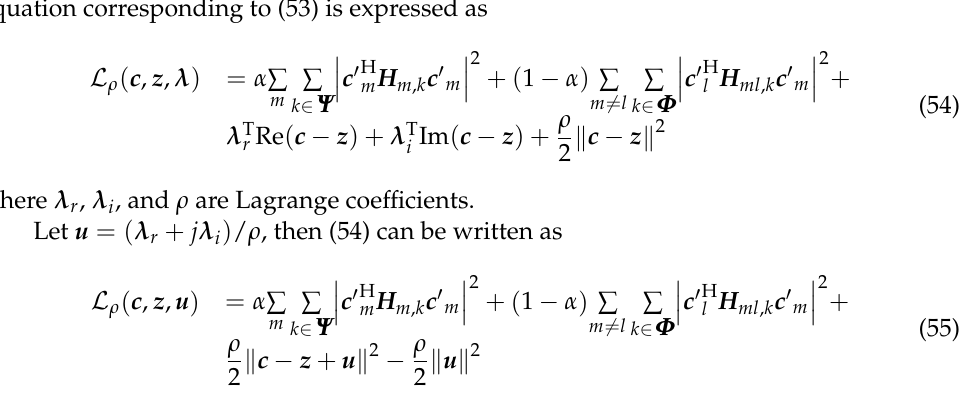
Table 2. To begin, initialize c , z , and u as c ( 0 ) , z ( 0 ) , u ( 0 ) . Next, repeat steps b) to e) until the number of iterations reaches the upper limit—i.e., positive number (or until the iteration stop condition is